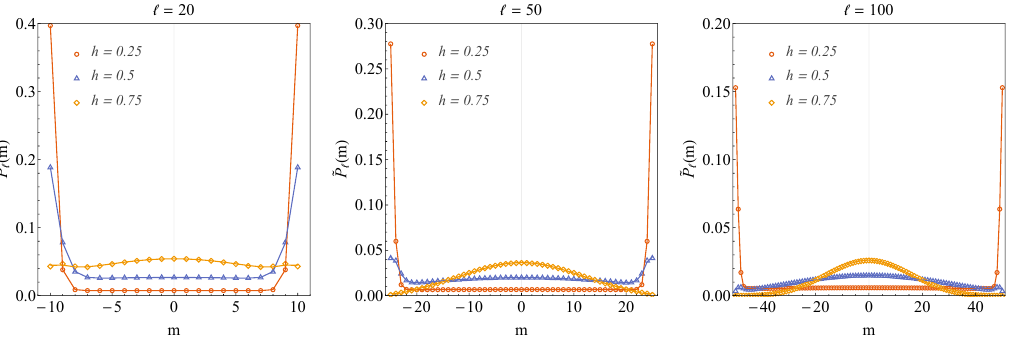
Figure 9: Exact stationary PDF obtained by Fourier transforming Eq. (48) (symbols) is compared with the best-fit phenomenological description given by Eq. (80) (full